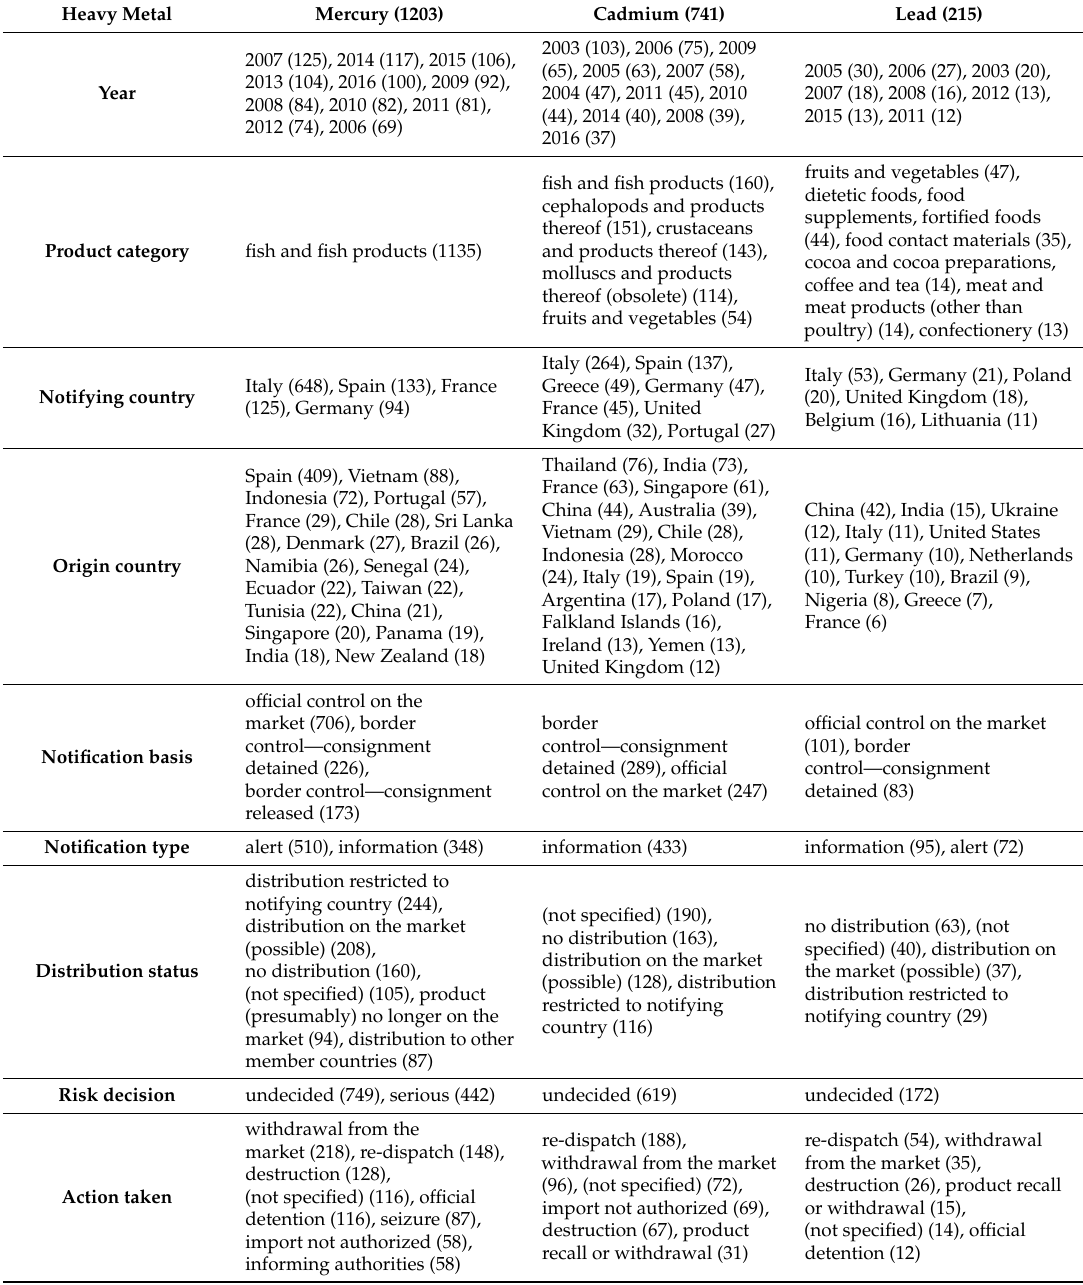
Table 1. Numbers of notifications of heavy metals within